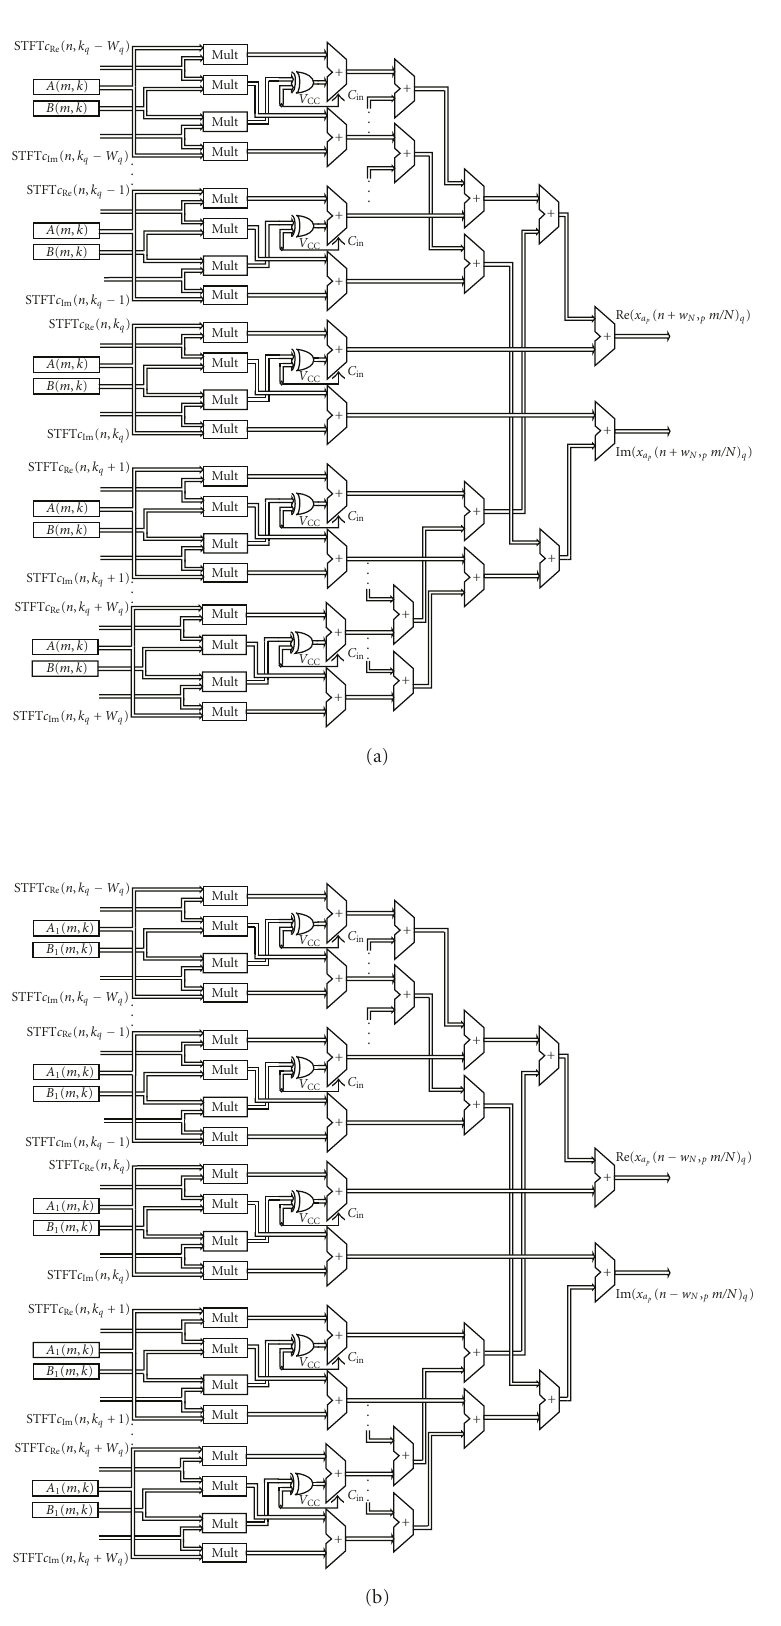
Figure 3: Architecture for producing of signal with complex-lag argument: (a) x a